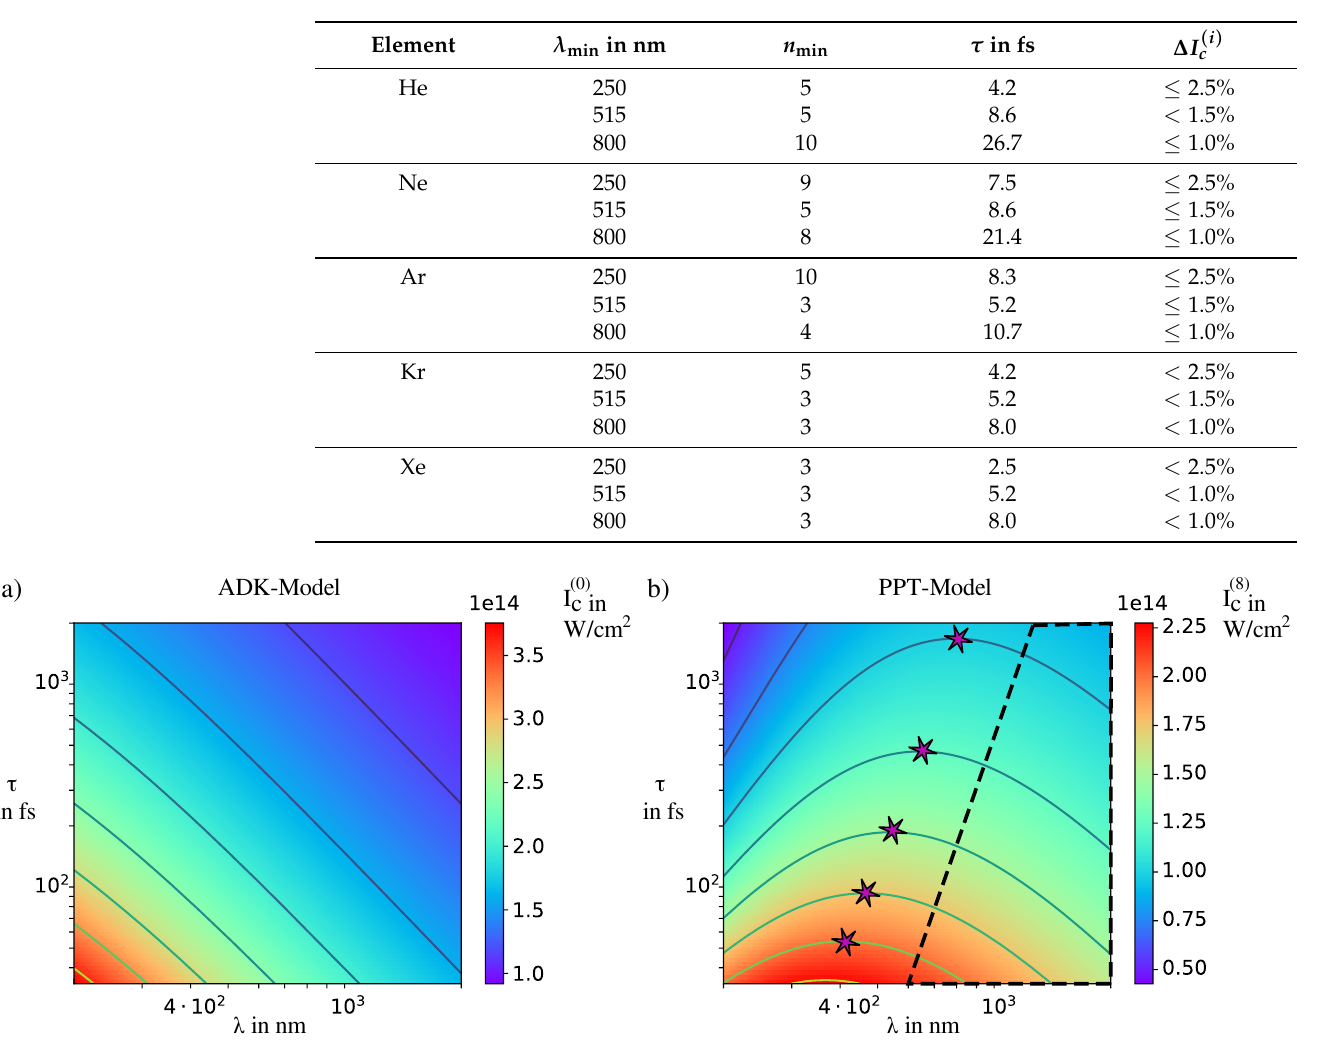
Figure 4. Density plots of the critical intensity in argon calculated within the ADK model ( a ), and the PPT model for iteration step i = 8 ( b ). The critical intensity is shown for an incident wavelength from λ = 200nm to 2000nm (log scale) and a pulse duration of τ = 40fs up to τ = 2000fs (log scale). The inset in ( b ) denotes the parameter space for which the critical intensity calculated within the PPT model scales similarly (approximately linear contour lines) to the critical intensity calculated by the ADK model ( a